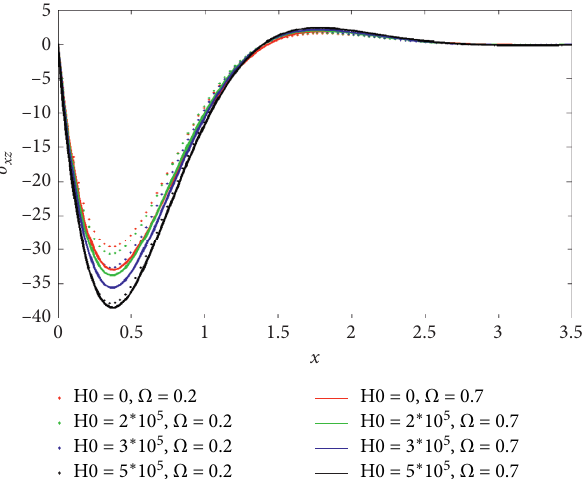
Figure 32: Stress τ rotation.